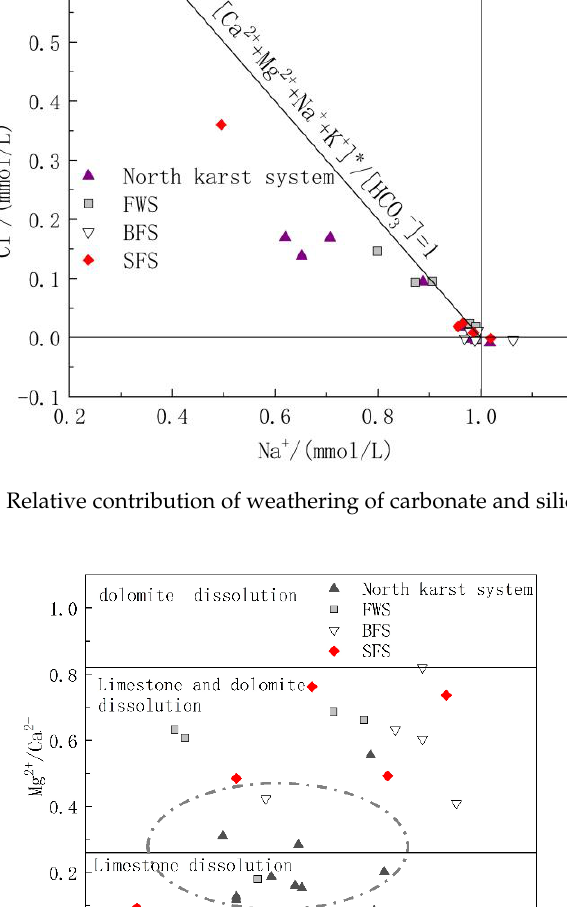
Figure 7. Relationship of Mg 2+ /Ca 2+ and SO 42− in underground water samples. 5.1.3. Analysis of Hydrochemical Characteristics along the Underground River Systems Analysis of the composition and proportion of the main ions revealed that the karst conduit systems in the north of the Gu Song River were obviously different from those in the FWS, BFS and SFS. Considering the natural separation of the Gu Song River from the karst systems, this section focused on analysis of the hydrochemistry characteristics along the runoff path of the adjacent FWS and north karst conduit systems to further distinguish the differences between them. The karst conduits in the north are densely developed, with short runoff paths and limited recharge areas. These characteristics result in small-scale development of branches in the north area, and the branches have no obvious impact on the water quality of the main conduits. As shown in Figure 8a, the concentrations of total dissolved solids (TDS), HCO 3− and other main ions in the north karst conduits are positively related to the runoff distance and negatively related to the elevation. The TDS was found to increase from 190 to 399 mg/L and the SIC from −0.0891 to 0.3024 from the recharge areas to the outlets. The carbonate rock strata along the karst conduits are dominated by limestone; therefore, even though the SID fluctuates, it was not found to be correlated with other elements. There are four karst conduits with a length of more than 2 km in the FSW, and the impact of branches on the water quality of the main conduits cannot be ignored. As shown in Figure 8b, from the recharge area of FWS to sampling point GW13 (elevation of 920 m), the concentrations of TDS, HCO 3− and other main ions were basically positively correlated with the runoff distance, and the peaks of TDS and HCO 3− were 358 and 220 mg/L, respectively. These findings were influenced by the water inflows from conduit branches, while TDS and HCO 3− were reduced to 237 and 149 mg/L, respectively, at the outlet. The elevation of the branch sampling points GW15 and GW16 was 710–